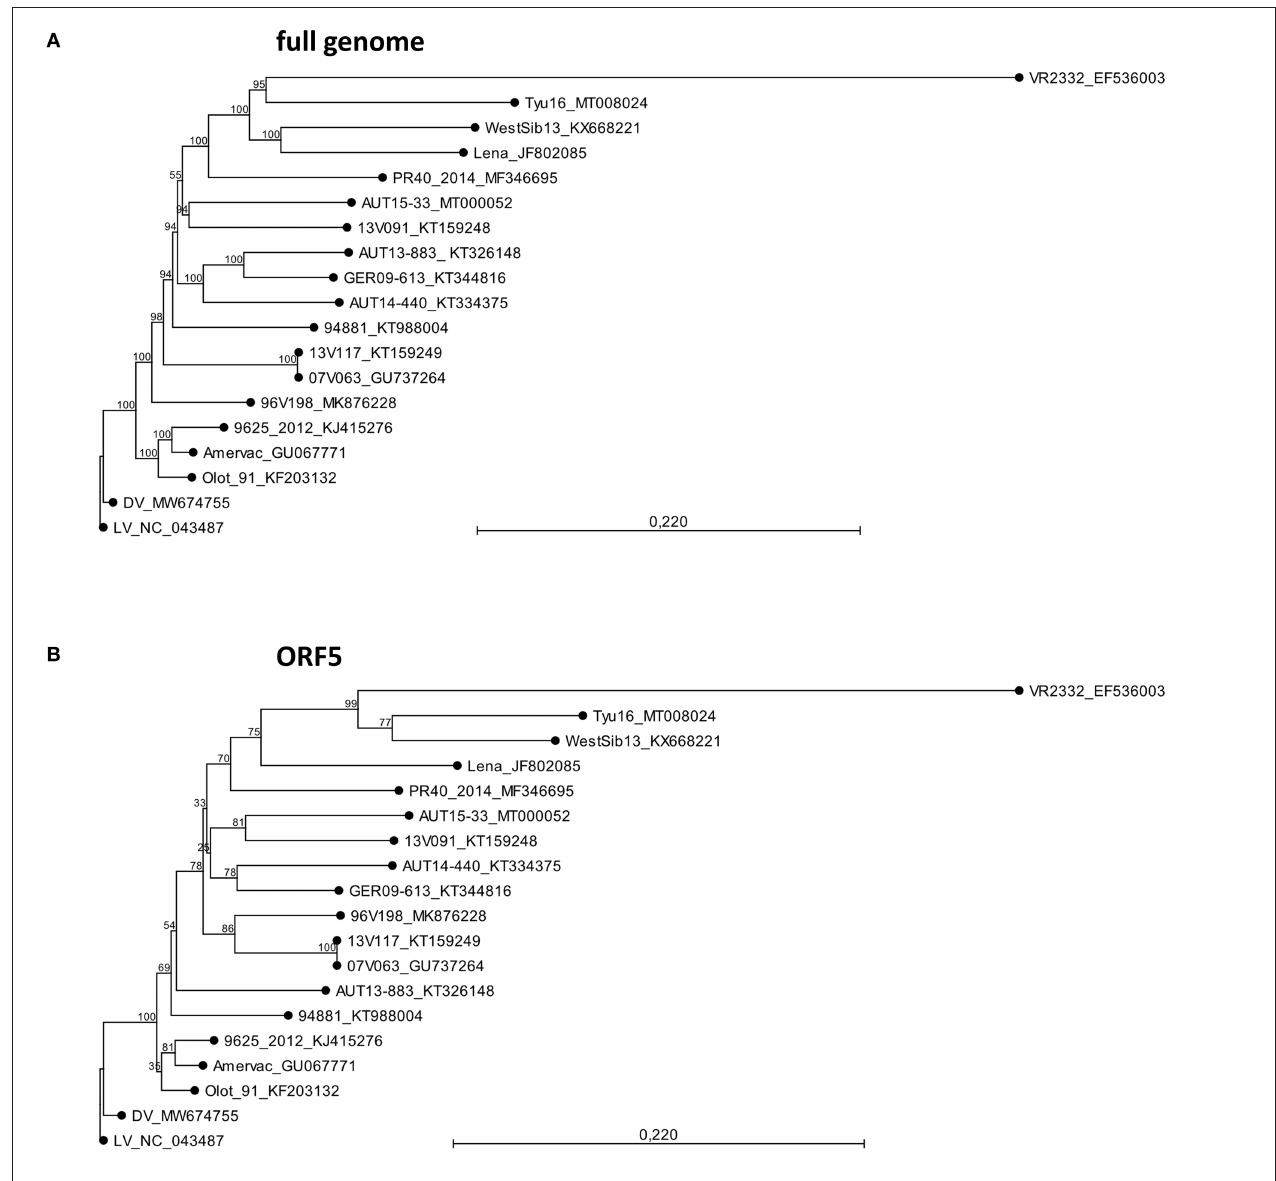
FIGURE 2 | Phylogeny calculations with selected porcine reproductive and respiratory syndrome virus strains for the full genome (A) and ORF5 sequences (B) . The phylogenetic trees were calculated in CLC workbench package by neighbor joining method with a Kimura 80 algorithm. The bootstrap analysis was set to 1,000 replicates. Both phylogenetic trees are rooted to LV. The scale bar indicates the number of nucleotide substitutions per site.